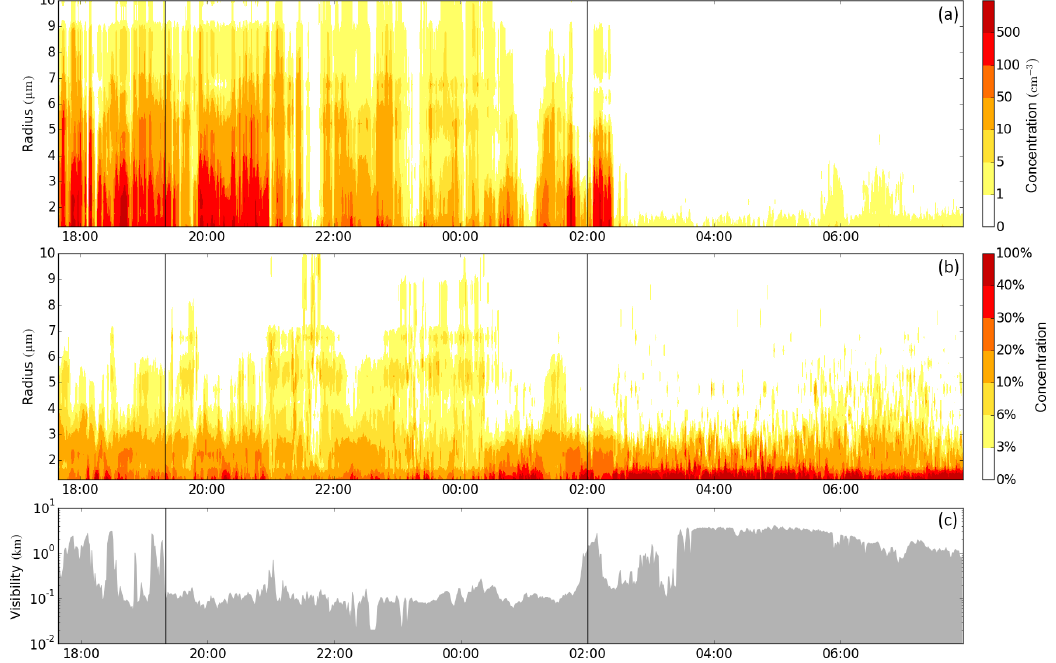
Figure 3. Temporal evolution of the collected data during Fog Event 2: ( a ) absolute drop counts ( b ) relative drop counts ( c ) visibility. Vertical lines mark stage transitions.